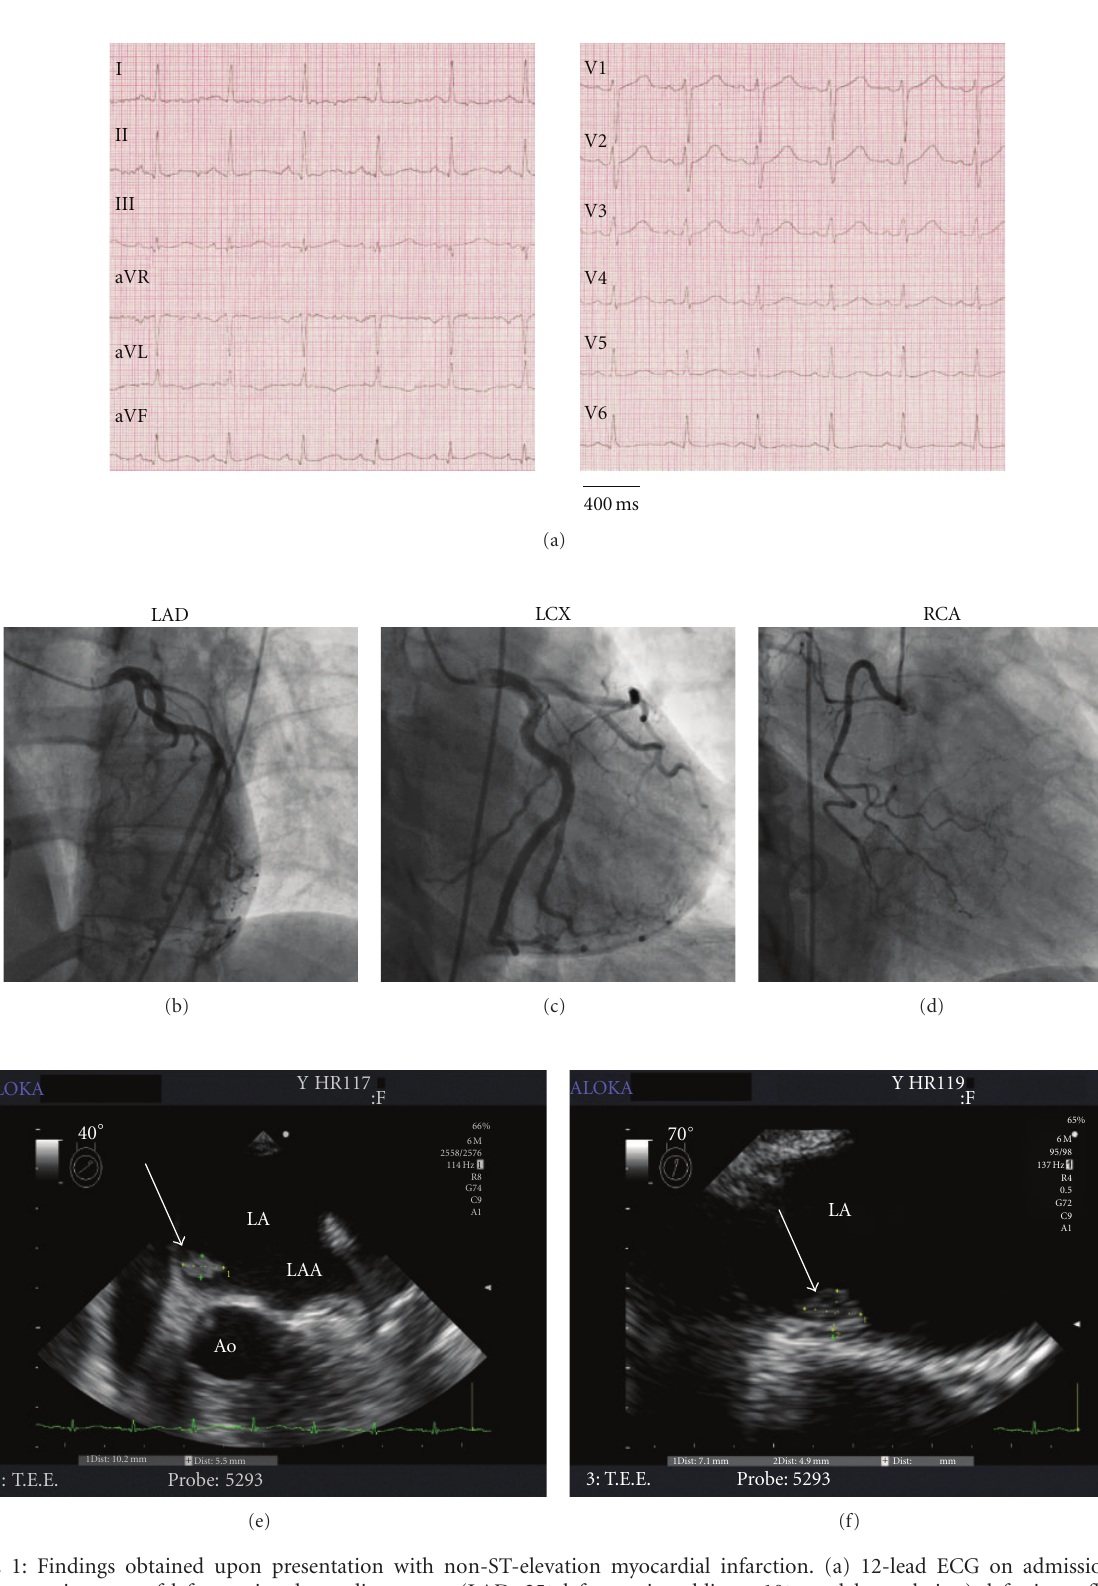
Figure 1: Findings obtained upon presentation with non-ST-elevation myocardial infarction. (a) 12-lead ECG on admission. (b–d) Coronary angiograms of left anterior descending artery (LAD; 25 ◦ left anterior oblique, 10 ◦ caudal angulation), left circumflex artery (LCX; 10 ◦ right anterior oblique, 30 ◦ caudal angulation), and right coronary artery (RCA; 30 ◦ right anterior oblique), revealing no signs of remaining thromboembolus or atherosclerosis. (e, f) Transesophageal echocardiograms, showing a left atrial tumor (arrow) located at the interatrial septum (40 ◦ (e) and 70 ◦ (f) angulation relative to the transversal plane, resp.). LA: left atrium; LAA: left atrial appendage; Ao: aorta. See text for